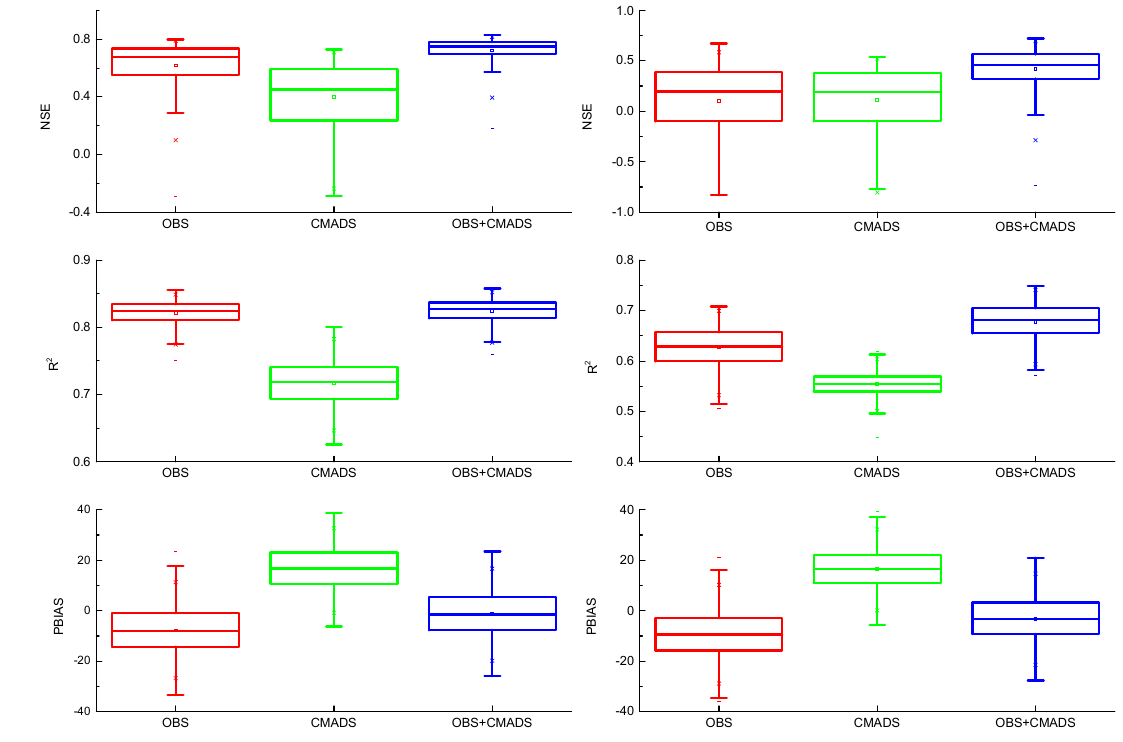
Figure 12. The box plots for the criteria of NSE ( top ), R 2 ( medium ) and PBIAS ( bottom ) during calibration period ( left ) and validation period ( right ). The square symbol and middle line in the box represent the mean value and median value, respectively. Each box ranges from the lower (25th) to upper quartile (75th). PBIAS: percent bias.